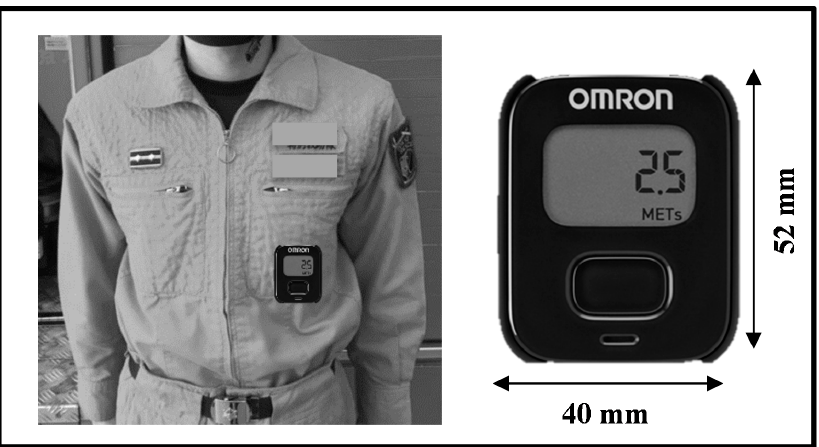
Figure 1. Placement of to wear a tri-axial accelerometer (Omron activity meter, Active style PRO HJA-750C—23 g, 40 × 52 × 12 mm; Omron Healthcare Co., Ltd. Kyoto, Japan). The base part of the chest pocket (length-16.2 cm, width-15.3 cm) is located near the waist area (about 10 cm above the belt part).